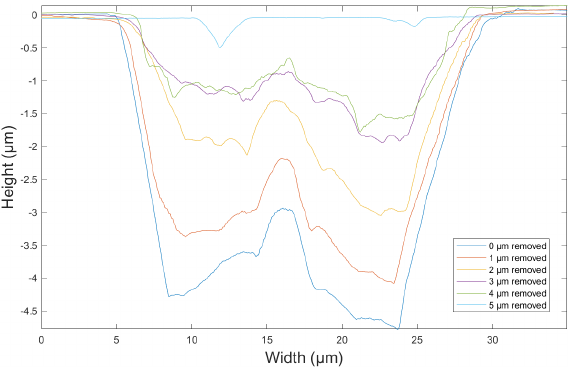
Figure 4. The graphs of damage profile structure.